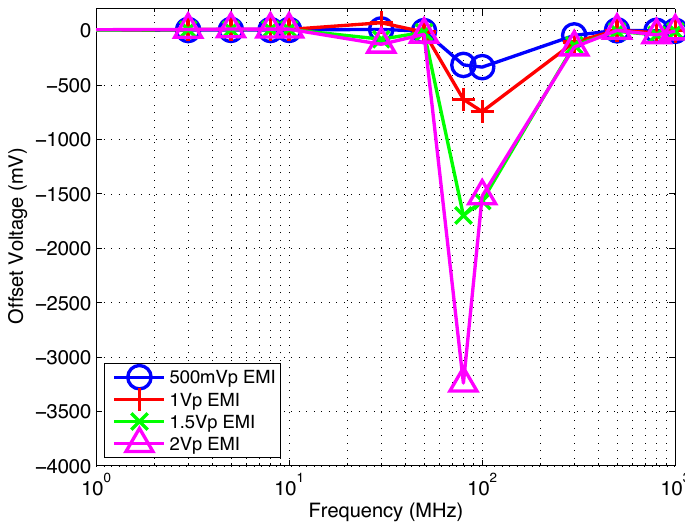
Figure 4. EMI induced offset in OPA705: interferences coupled to the output